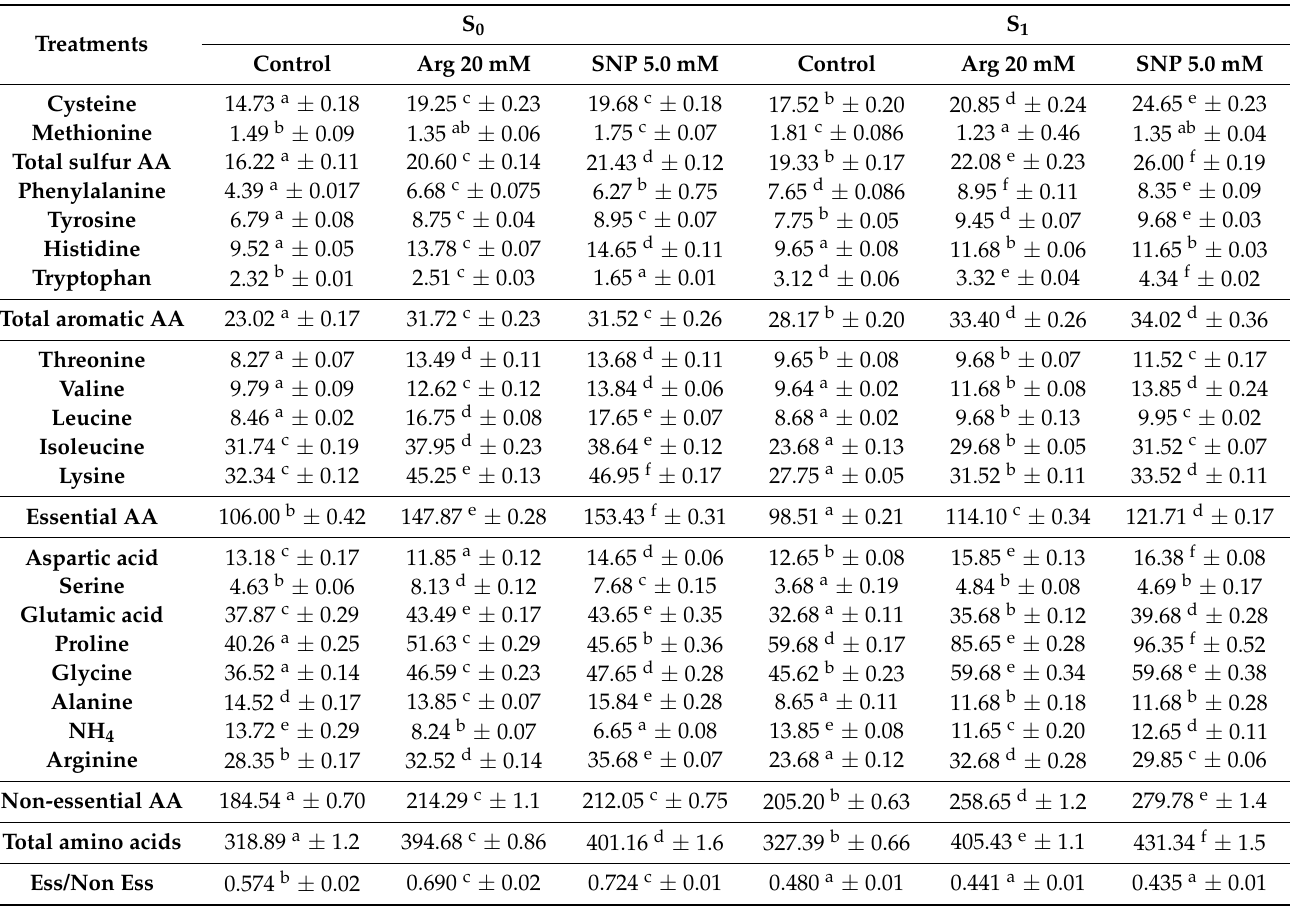
Table 5. Effect of arginine (20 mM) or SNP (5.0 mM) on individual amino acids composition